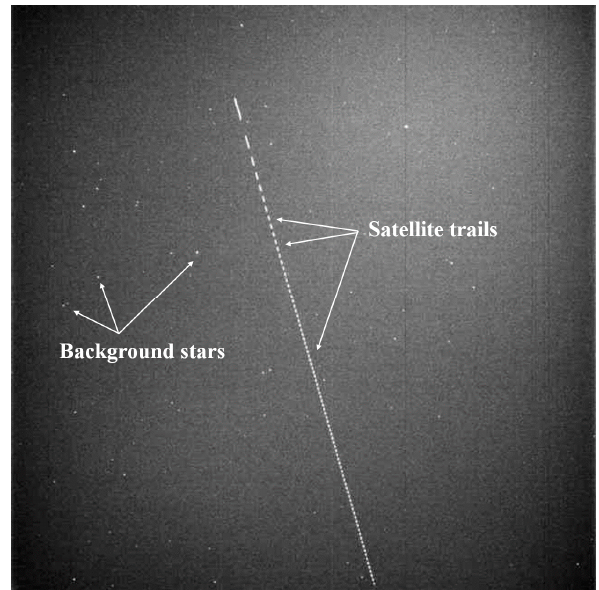
Figure 1. Optical observation image of CRYOSAT 2 on 1 June 2016 at the Israel site of the Optical Wide-field patroL-Network (OWL-Net). CRYOSAT 2 observed on sidereal tracking at the maximum chopper speed. The longer trails are the start of the observation.